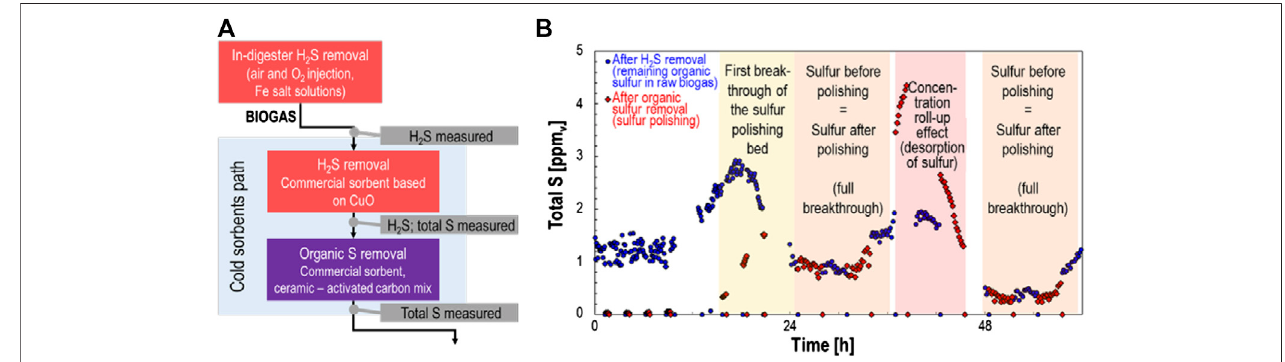
FIGURE2| Exampleoftheuseofa fi eld test toevaluate thecapacity ofsorbents for trace sulfur compounds in biogas. Thebiogaswasproduced from agricultural waste and food/green waste and contained undetectable levels of siloxanes. (A) Shows a schematic representation of the biogas treatment steps, and (B) shows the resulting total sulfur measurements after different stages of biogas